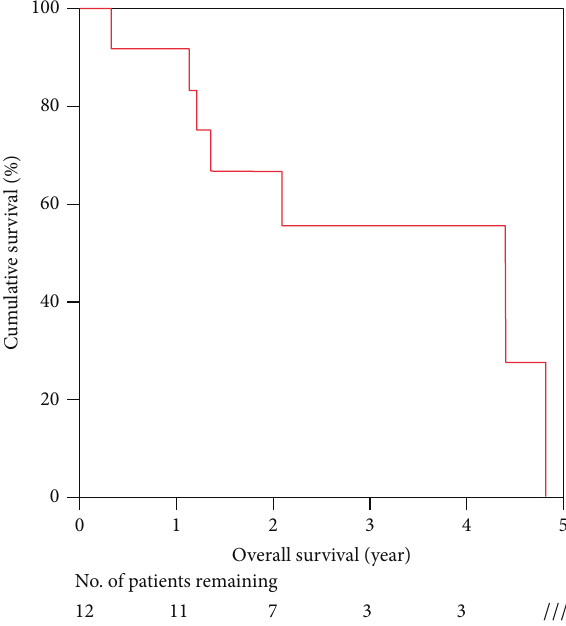
Figure 1: Overall survival of NELM patient after hepatectomy.